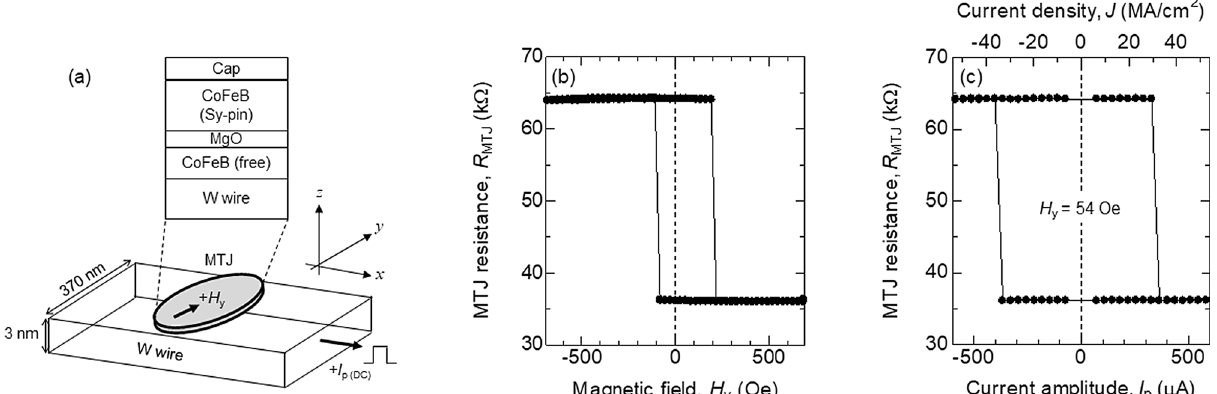
Figure 1. ( a ) Schematic illustration of type-Y three terminal magnetic tunnel junction (MTJ) including the film stacking. The coordinate axis is depicted together. ( b ) H y dependence of the MTJ resistance R MTJ at room temperature. ( c ) R MTJ plotted as a function of the current pulse amplitude measured while a bias field of H y ~ 54 Oe is applied. The duration of current pulse is ~ 50